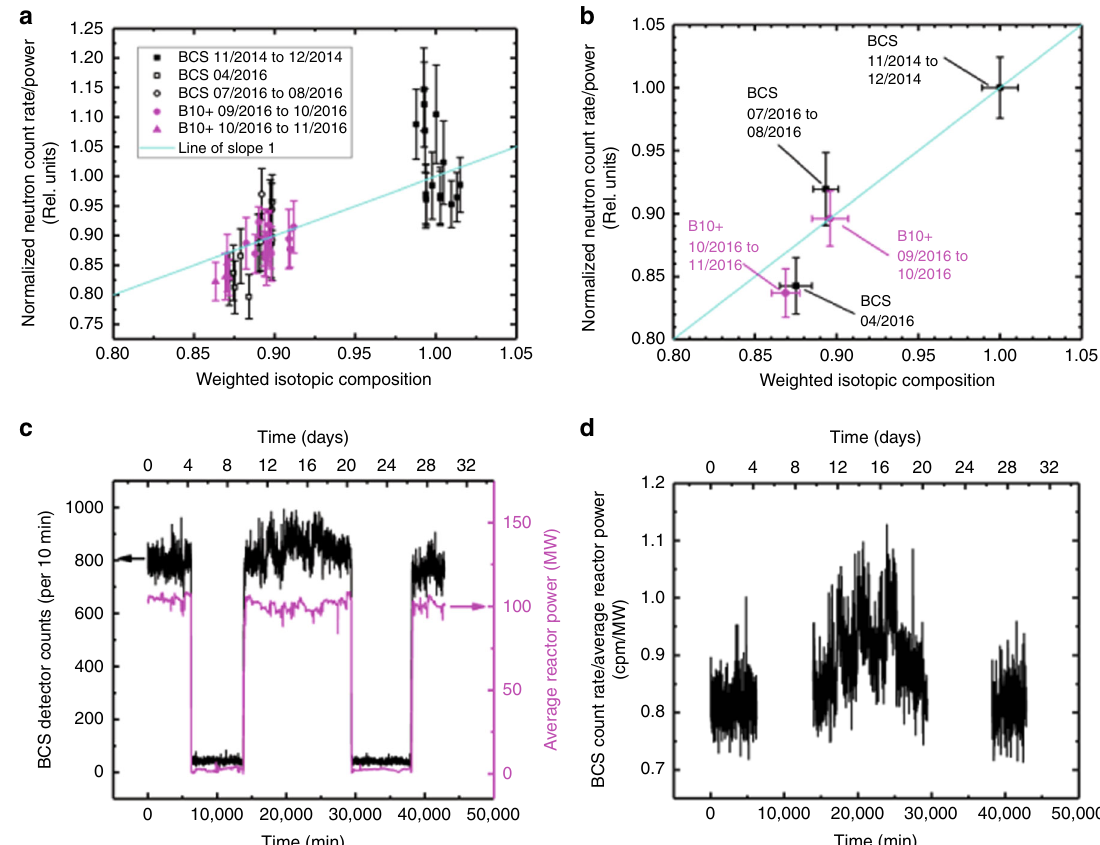
Fig. 2 Dependence of neutron detector count rate on reactor power and isotopic inventory. a Relative measured neutron detector count rate (with background subtracted) per unit reactor power (ordinate) vs. weighted isotopic composition of the reactor core (abscissa). The abscissa values are determined by individual TRIAD simulation core followings during particular periods of time as indicated in the graph legend. The ordinate values are determined by neutron measurements conducted with either the boron-coated straw (BCS) detector or the B10 + detector at the time corresponding to each TRIAD core following. All quantities here are presented relative to a reference case, chosen as the average of data from the time period 2014/11 to 2014/12. Ordinate error bars are standard deviations of the normalized neutron count rates per unit power measured over the time period between each TRIAD core following calculation. The data points are plotted against a line of slope 1, with zero intercept. b Data from ( a ), averaged together in 1-month- long periods, as indicated in the graph. Data points in black squares were recorded at Location A with the BCS detector, and data points in magenta circles were recorded at Location B with the B10 + detector. These points collectively are seen to coincide well with a line of slope 1, and zero intercept. The error bars are standard deviations of the mean of data points from ( a ) for each time period. c Representative BCS detector count rate (at location A, from 2014/ 11 to 2014/12 time period) versus time, including periods of reactor start-up and shutdown. d Data from ( c ), relative to reactor power, and excluding shutdown periods, to illustrate how the detector count rate per unit reactor power can vary over the course of a